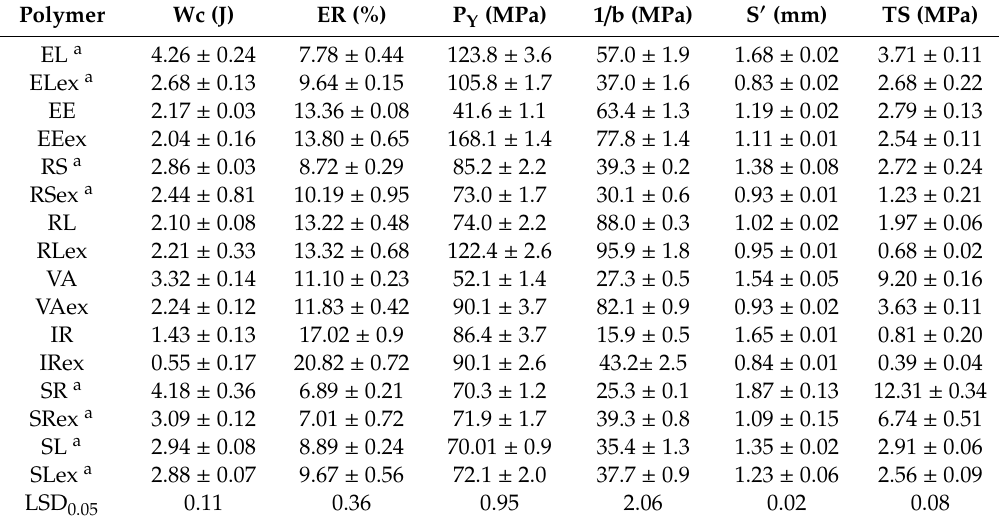
Table 6. Results of work of compaction (Wc), elastic recovery (ER%), yield pressure parameters (Heckel Py, Kawakita 1 / b, slope S (cid:48) of derivatized (dx / dF vs. 1 / F (cid:48) ) compression curves and tensile strength (TS) (mean values ± SD, n = 3 and LSD 0.025